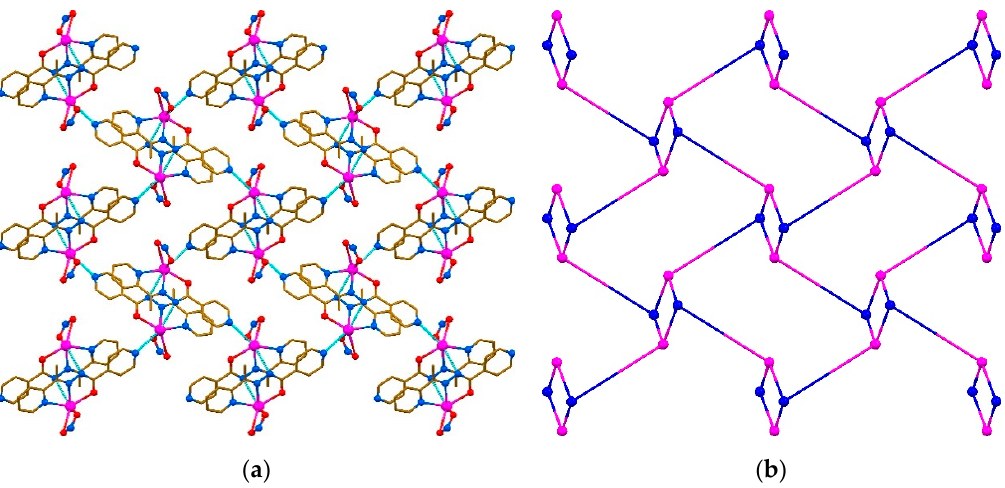
Figure 3. ( a ) View on the 2D supramolecular layer in the structure of [PbL(NO 2 )] n , formed through Pb ··· N = C(O) and Pb ··· N 4-Py tetrel bonds (H-atoms were omitted for clarity). Color code: C = gold, N = blue, O = red, and Pb = magenta; cyan dashed line = Pb ··· N tetrel bond. ( b ) Simplified underlying network of [PbL(NO 2 )] n , considering all Pb ··· N tetrel bonds, with the uninodal 3-connected fes (Shubnikov plane net) topology defined by the point symbol of (4 · 8 2 ). Color code: Pb = magenta, and L = blue.